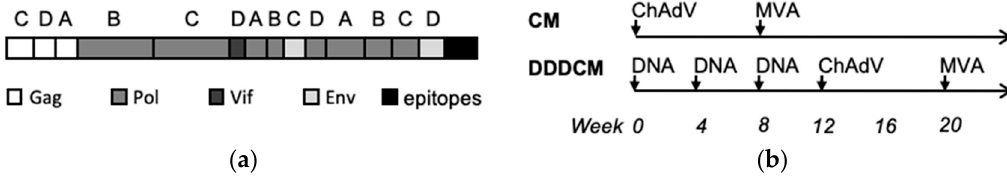
Figure 1. The HIVconsv immunogen and vaccination. ( a ) Schematic representation of the HIVconsv immunogen derived from 14 conserved regions of the HIV-1 proteome. For each segment, the clade of consensus amino acid sequence is shown above and the HIV-1 proteins from which it was derived are color-coded. C-terminal CD8 + T-cell and monoclonal antibody epitopes were added to facilitate preclinical vaccine development and manufacture. ( b ) Two vaccination regimens used for the volunteers of this study. ChAdV—ChAdV63.HIVconsv; MVA—MVA.HIVconsv; DNA—pSG2.HIVconsv. Table 1. HIV-CORE 002 vaccine recipients, tissue types, regimens, and peak IFN- γ ELISPOT assay responses induced by the HIVconsv vaccines.